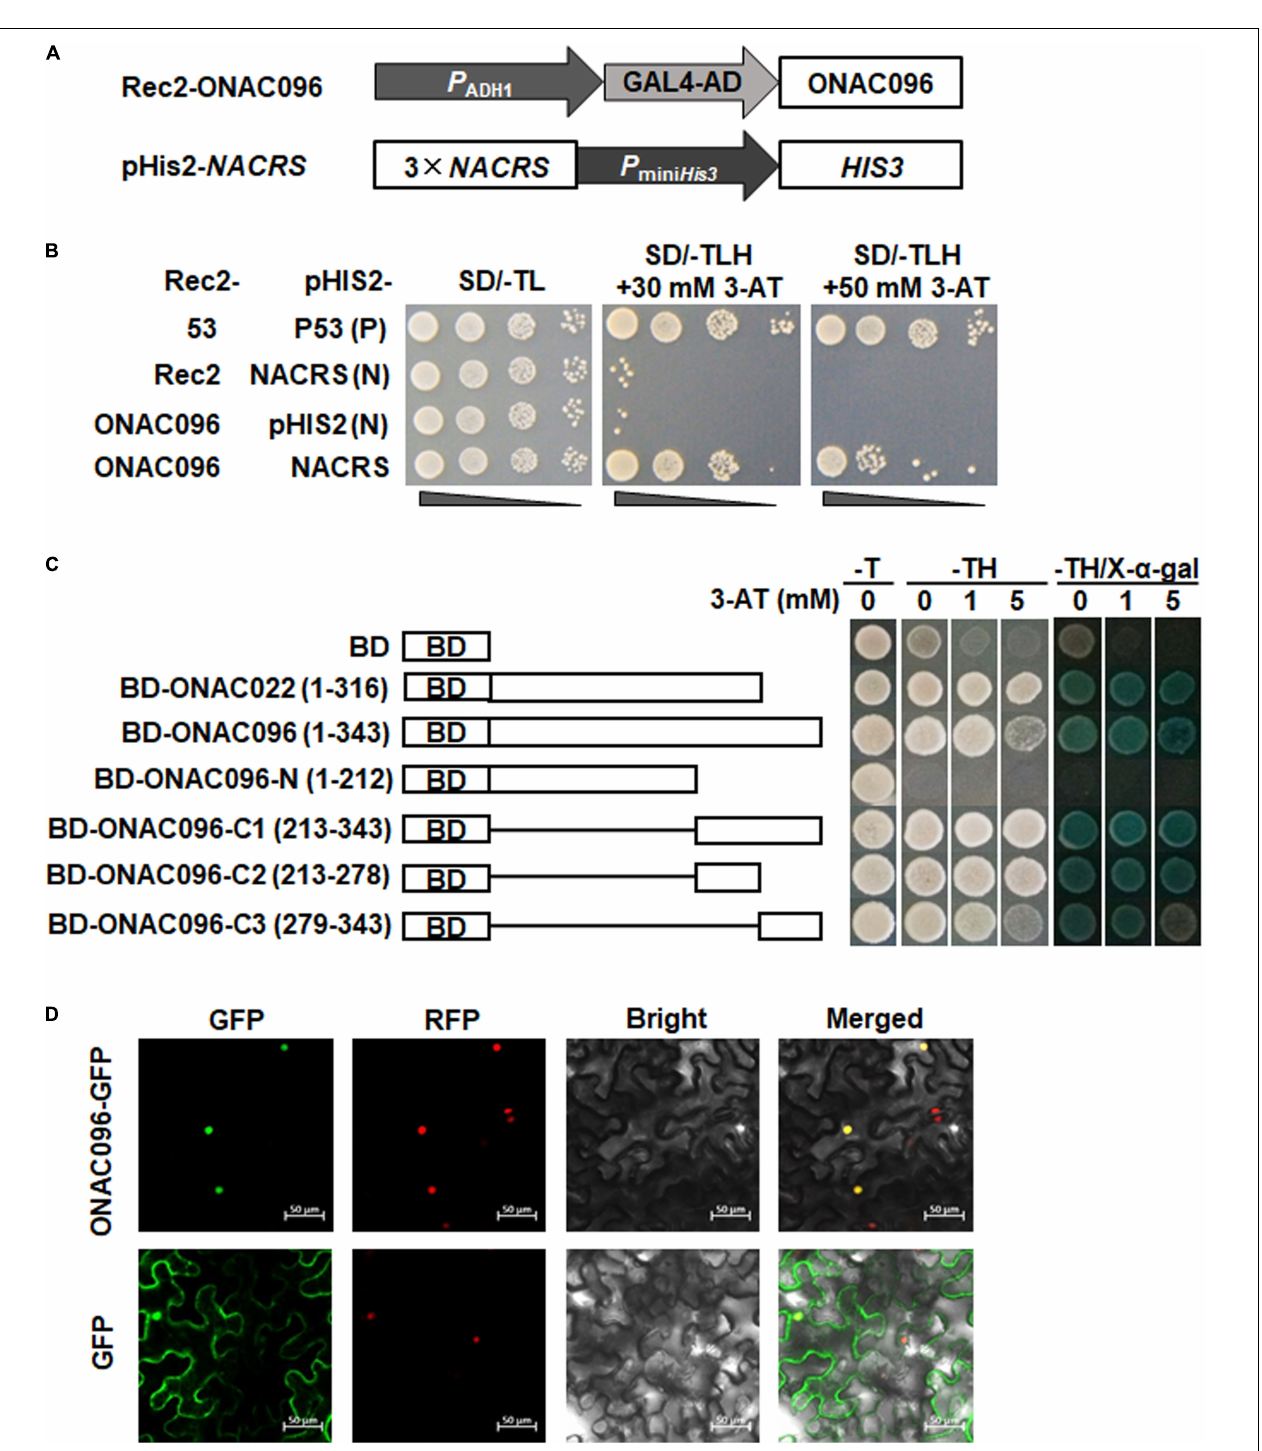
FIGURE 2 | DNA binding and transactivation activities and subcellular localization of ONAC096 protein. (A) Schematic diagram of plasmid constructs used in ONAC096- NACRS binding assay. (B) ONAC096 binds to NACRS in yeast cells. Yeast cells co-transformed with indicated pairs of Rec2 and pHis2 vectors were incubated on SD/-Trp-Leu plates at 30 ◦ C for 3 days and were dropped by a series of 10-fold dilutions on plates of SD/-Trp-Leu, SD/-Trp-Leu-His/30 mM 3-AT, and SD/-Trp-Leu-His/50 mM 3-AT. Transformants harboring Rec2-53 and pHis2-P53 were used as positive controls whereas transformants carrying Rec2 and pHis2- NACRS or carrying Rec2-ONAC096 and pHis2 were used as negative controls. (C) ONAC096 has transactivation activity in yeast cells. Full sequence and truncated mutants of ONAC096 were fused to GAL4 DNA-binding domain in pGBKT7 vector. Yeast cells harboring each of the different truncated and